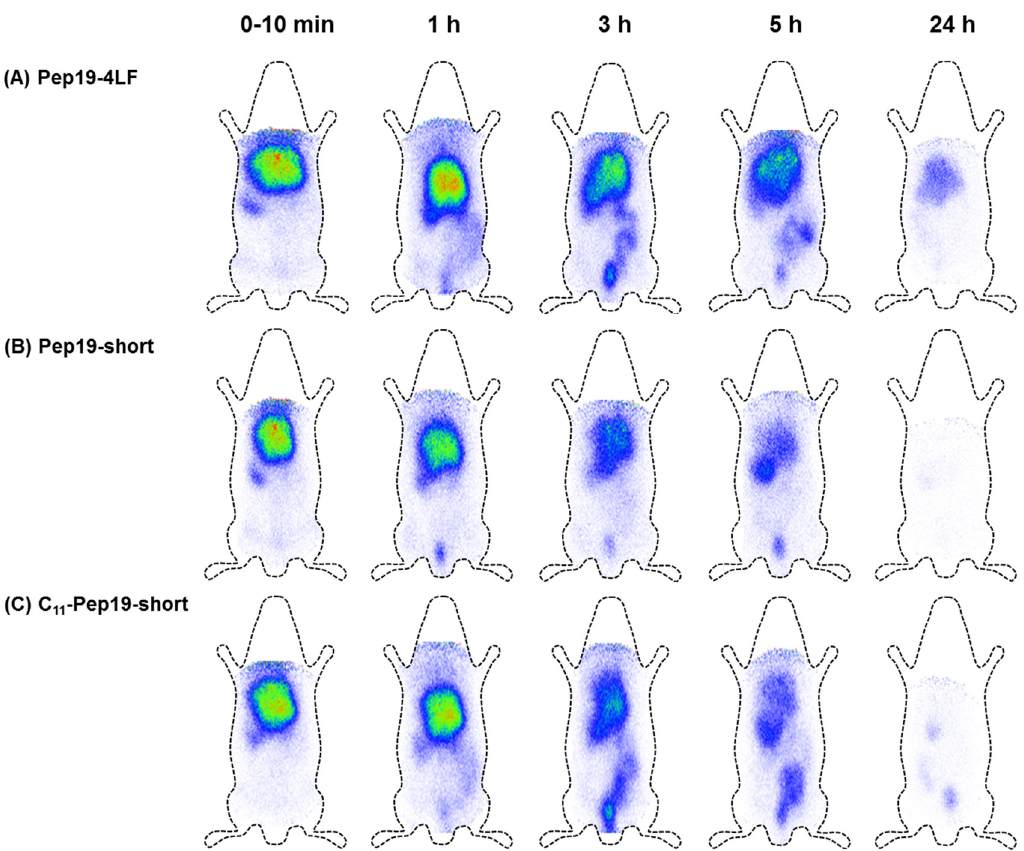
Figure 4. Scintigraphical images of ( A ) Pep19-4LF, ( B ) Pep19-short, and ( C ) C11-Pep19-short. The peptides were labeled with 125 I and injected intravenously into the tail vein of female Wistar rats, the images were recorded 0–24 h post administration. All peptides showed comparable pharmakokinetics with fast liver enrichment and subsequent hepatobiliary excretion.